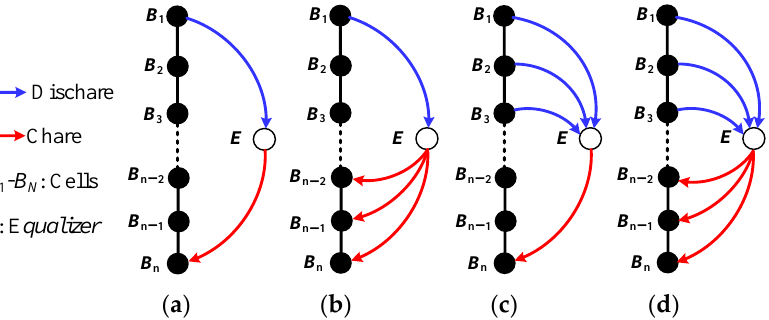
Figure 2. Possible operation modes of the proposed equalizer. ( a ) 1-1 mode. ( b ) 1-3 mode. ( c ) 3-1 mode. ( d ) 3-3 mode.